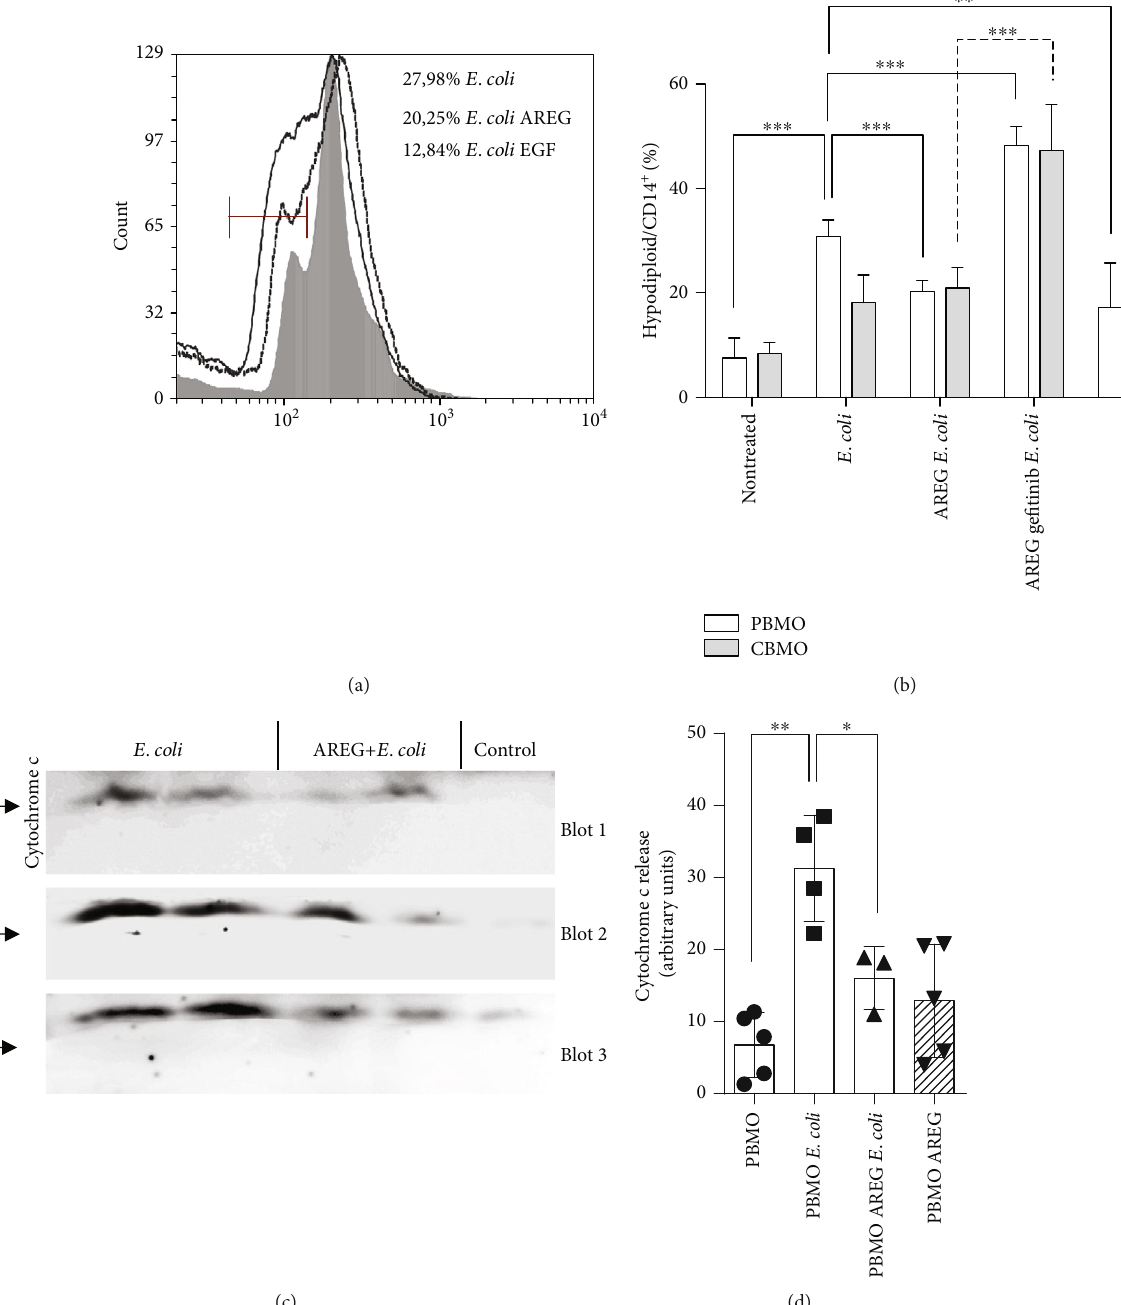
Figure 5: Quanti fi cation of PICD via detection of hypodiploid nuclei in PBMO and CBMO. Representative histogram of apoptotic sub-G1 subpopulations of treated PBMO (a; full line: E. coli , dotted line: AREG and E. coli , and grey area: EGF and E. coli ). Statistical analysis of the Nicoletti assay 24 h p.i. (statistical analysis using nonpaired Student ’ s t -test with Welch correction; ∗∗ p < 0 : 01 ; ∗∗∗ p < 0 : 005 ). Immunoblots representing the cytochrome c release after indicated treatment of PBMO (c). Statistical analysis of cytochrome c release (d; nonpaired Student ’ s t -test with Welch correction; ∗ p < 0 : 05 ; ∗∗ p < 0 : 001